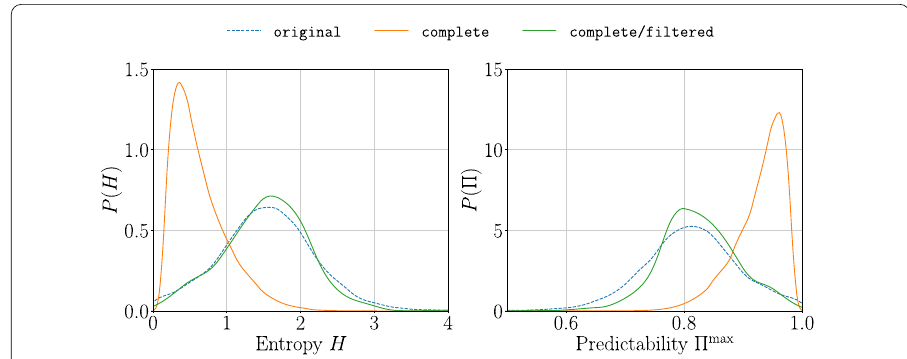
Figure 11 Revisited results from [4]. Distributions of the entropy and maximum theoretical predictability derived with (i) the incomplete original CDR-based trajectories of 8000 users filtered with the method in [4], (ii) the complete trajectories of all 1.7 million users, and (iii) the complete trajectories of the same 8000 users considered in the first